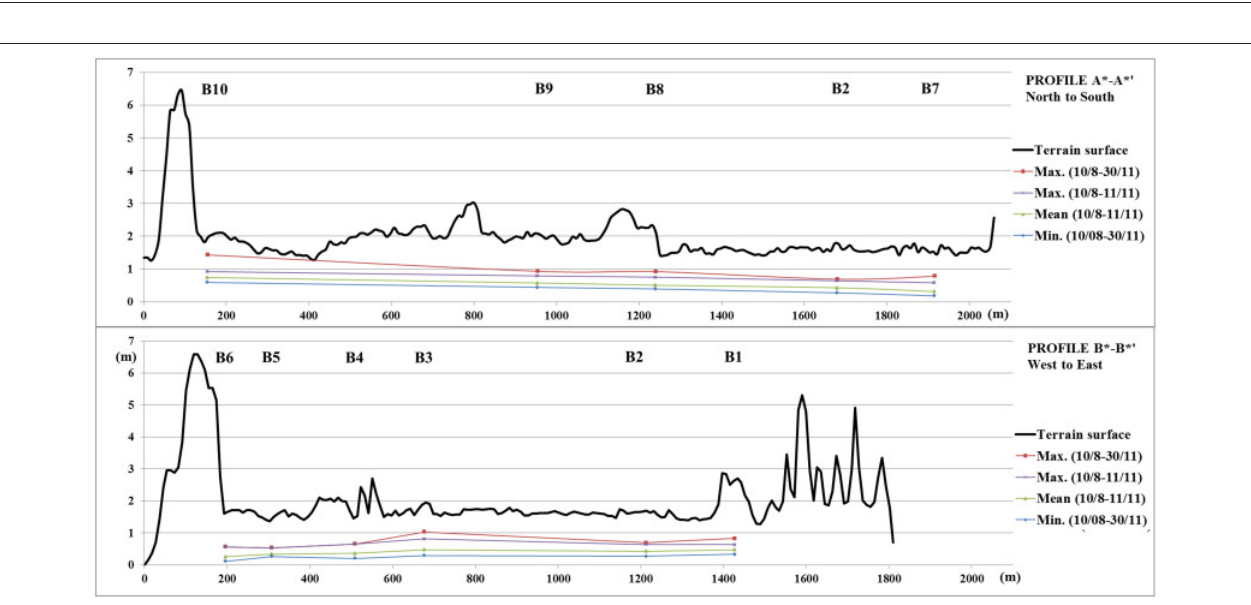
FIGURE 10 | Groundwater level. Terrain profiles A * -A * ′ (N-S) and B * -B * ′ (W-E) with measured maximum, mean and minimum groundwater levels from the station data series plotted. Total measuring period 5 Aug–30 Nov 2015 but due to the lack of from B4 to B6 in November, the mean and maximum have been calculated for the period 10/8–11/11. Lines between the stations are only indicative of the groundwater levels between stations. To the left (N and W, respectively) in both profiles the c. 6m high dike is seen. The “spikes” in profile A * toward E are mounds of sand and